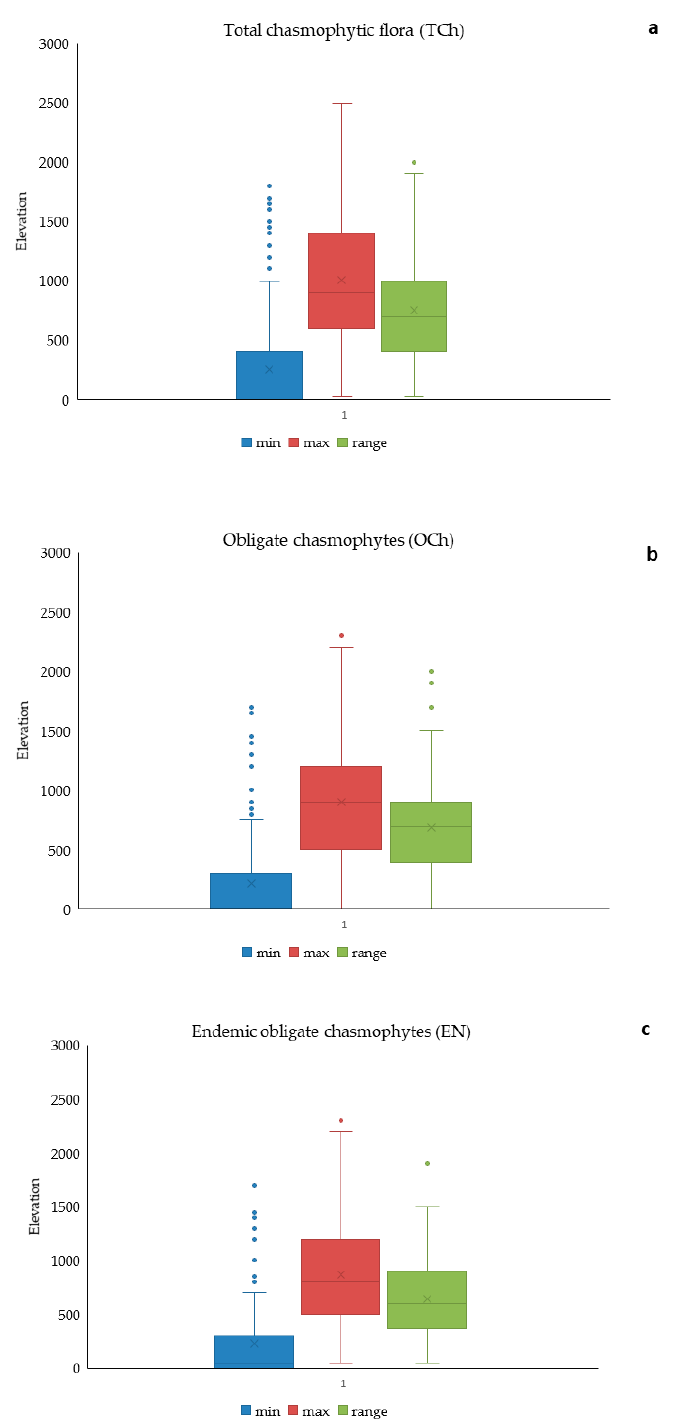
Figure 8. Boxplots of the minimum and maximum elevational distribution as well as the elevational ranges of ( a ) total (TCh), ( b ) obligate (OCh), and ( c ) endemic obligate (EN) chasmophytes of Crete. The horizontal line denotes the mean values, the box indicates the first and third quartiles, and outliers are plotted as individual points.